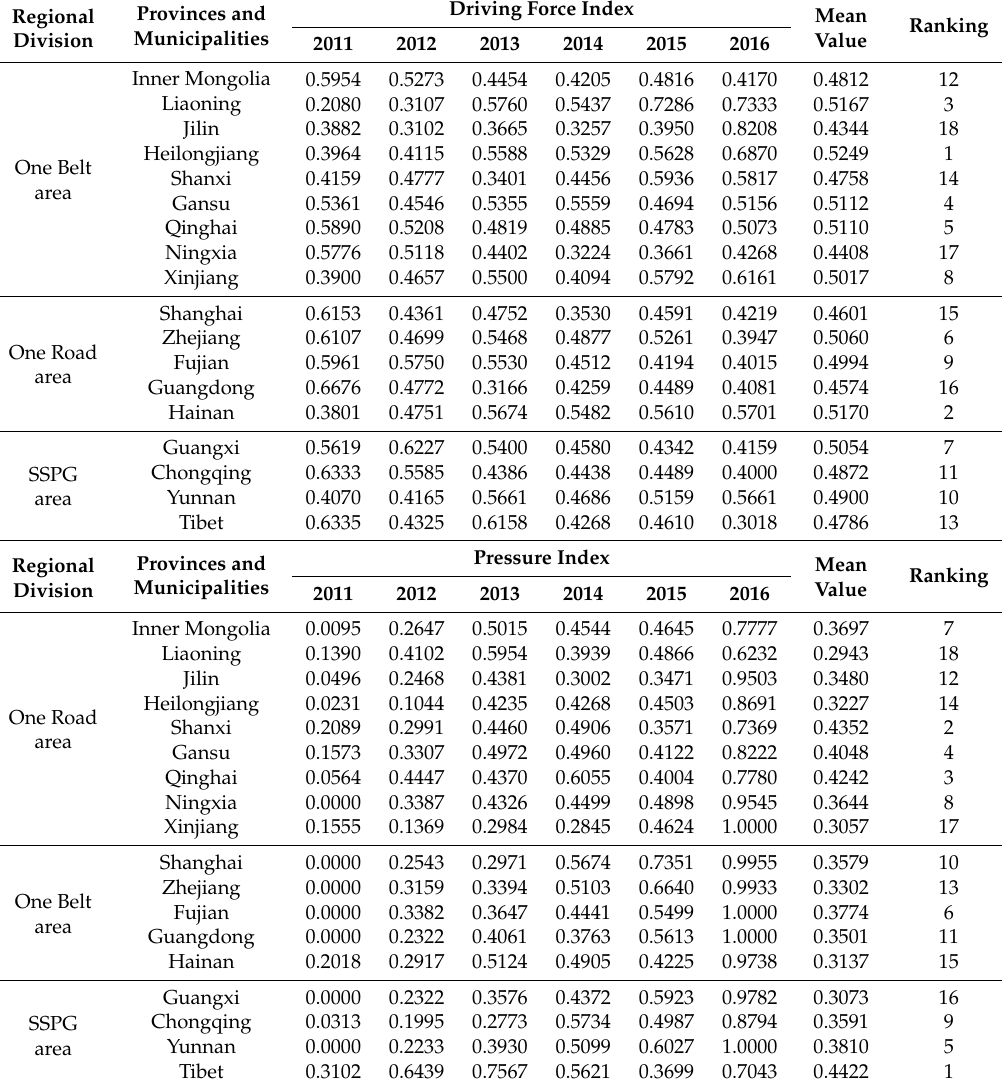
Table A4. The evaluation values of subsystems in the One Belt and One Road region of China from 2011 to